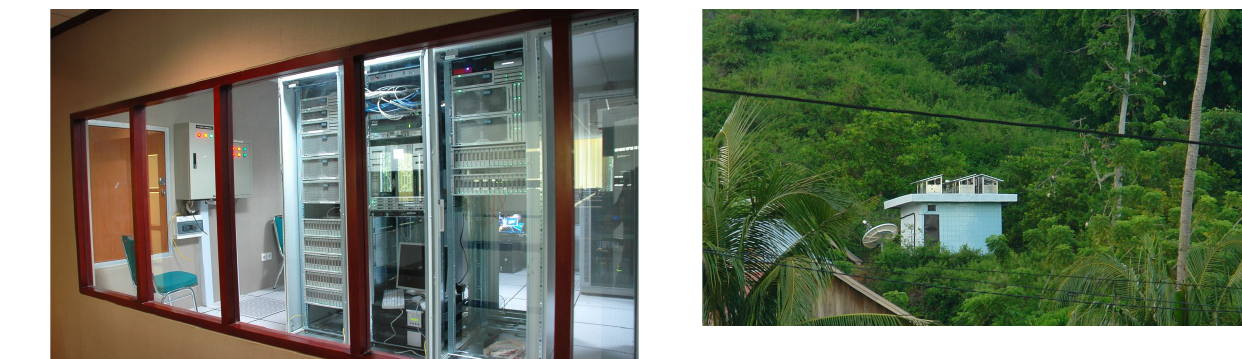
Fig. 17. Remote seismic sensor station with solar panels for the power supply of the sensors, the processing system and the commu- nication link (Sanana, Moluccas